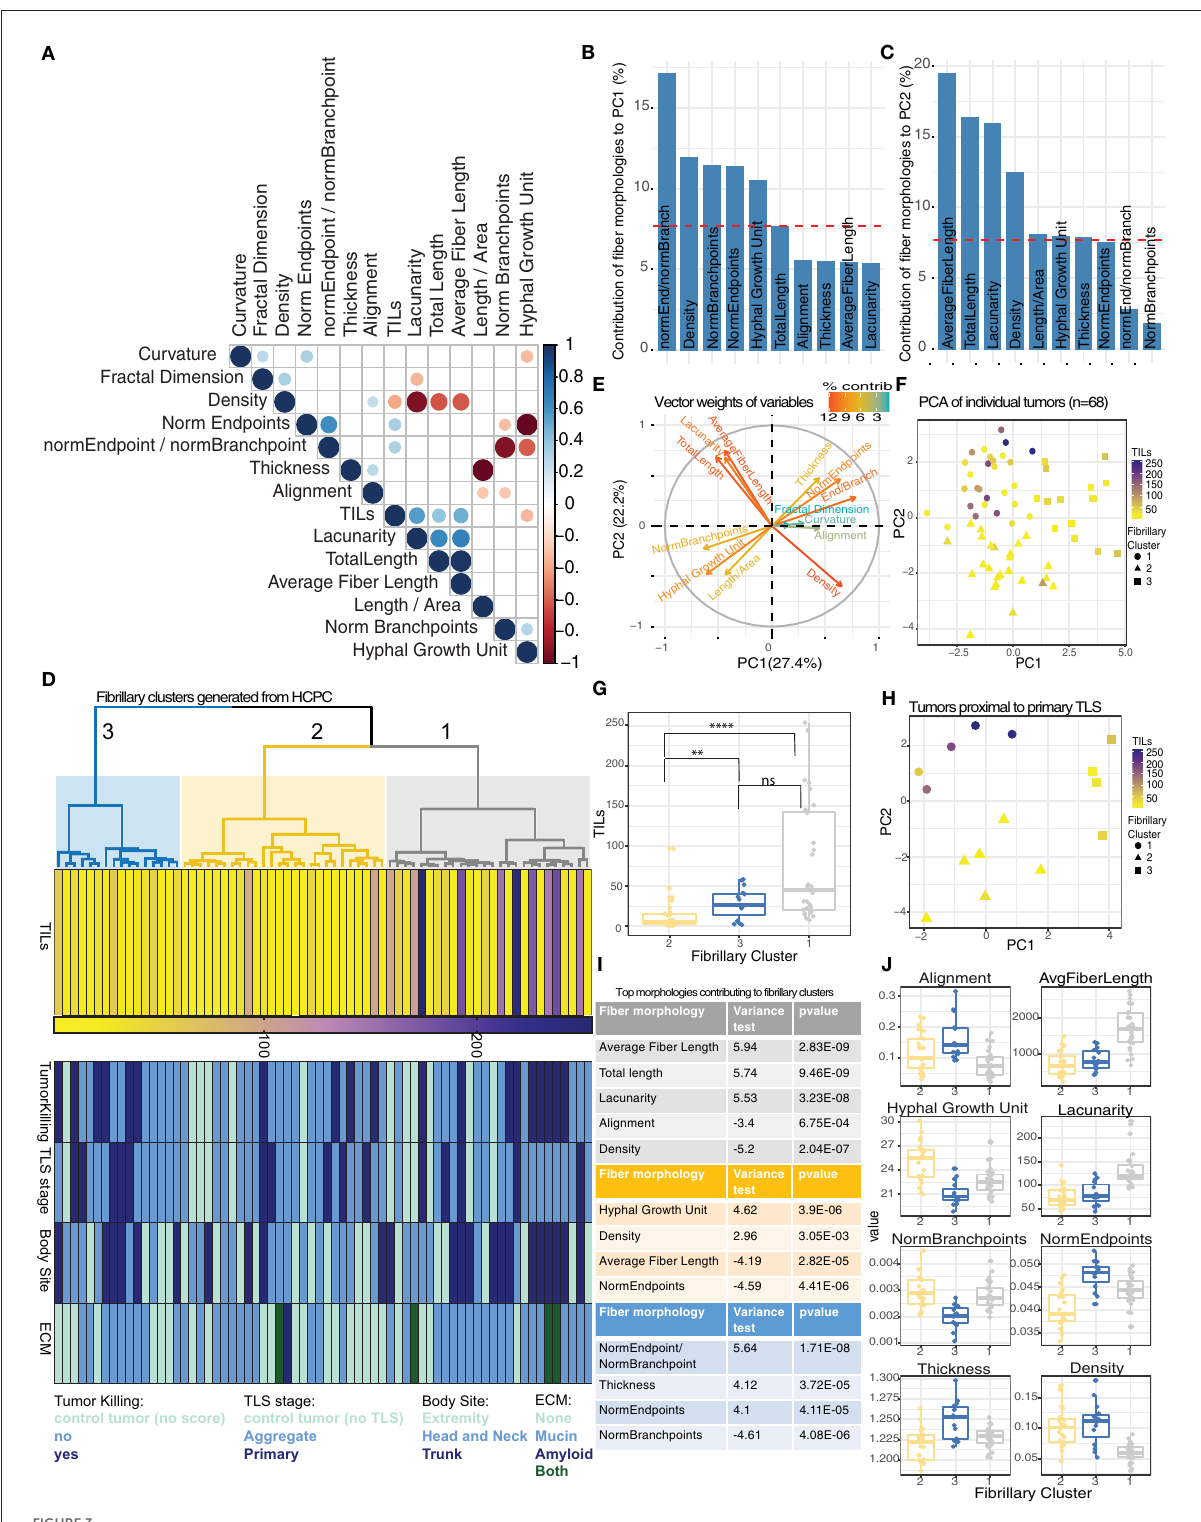
FIGURE3 Discrete morphologies in tumor-associated fibrillary matrix impact variation in TIL counts. (A) Correlation matrix reporting significant relationships (Spearman correlation, p- value < 0.05) among 13 fibrillary matrix morphologies and TIL counts for 68 tumors. (B,C)